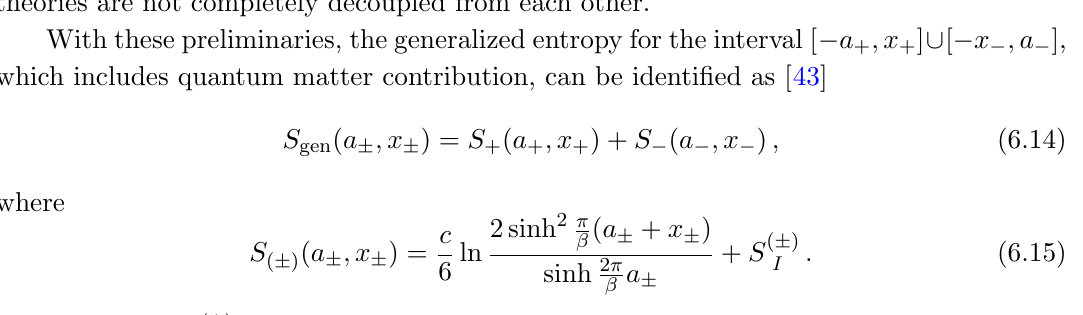
x (cid:0) ; t ) with each segment connected extremally. (cid:0) and Grav . In this sense, the ( ) + (cid:0) (cid:6)